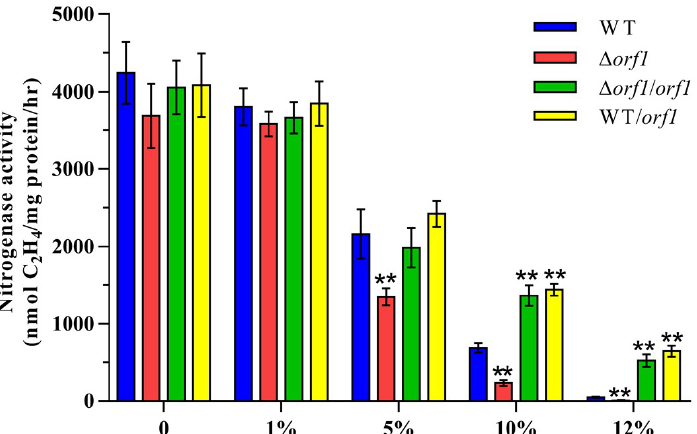
Figure 6. Effect of the different concentrations of O 2 on Nitrogenase activity of P. graminis RSA19 (WT), Δ orf1 (deletion mutant), Δ orf1 / orf1 (complementation strain) and WT/ orf1 (overexpression strain). The nitrogenase activities of these strains were assayed by the C 2 H 4 reduction method and